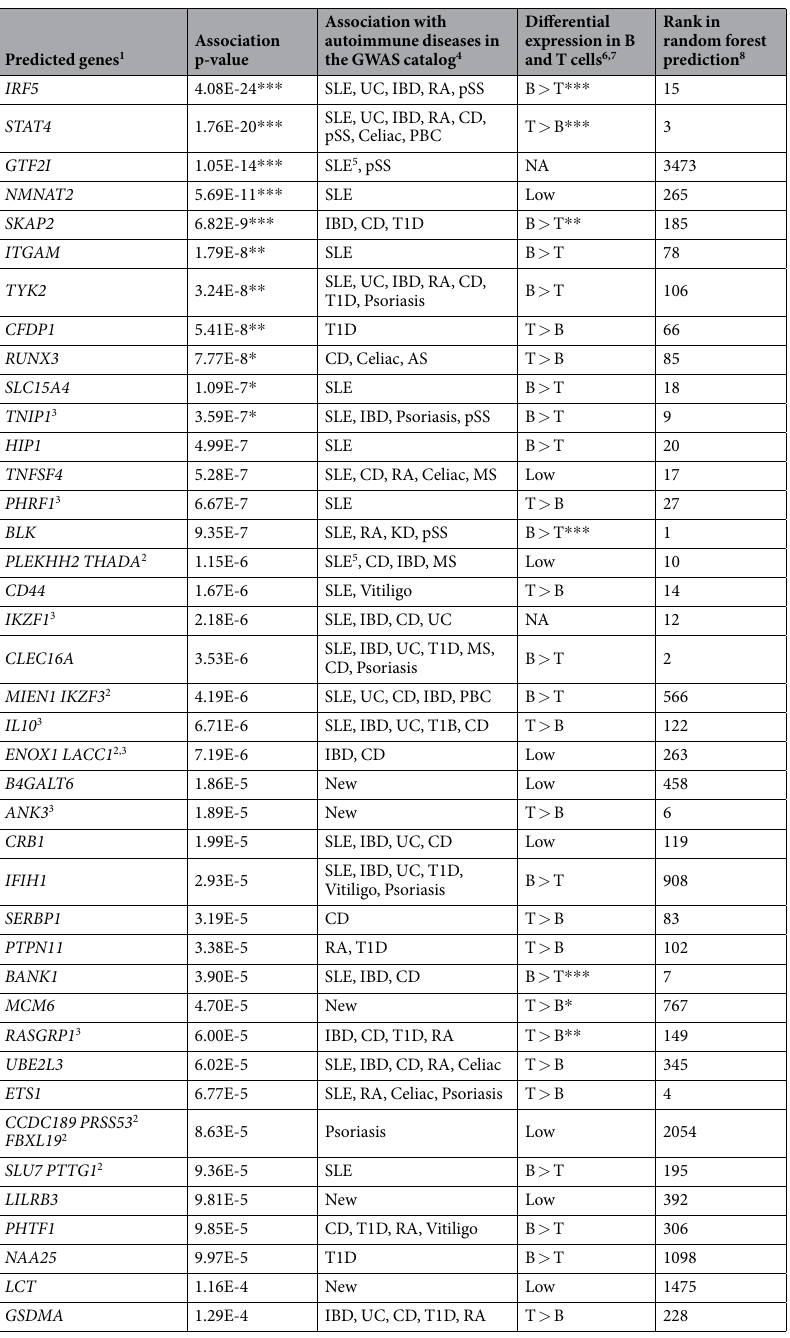
Table 2. Top 40 risk genes for SLE identified by the regular single SNP association using Immunochip genotype data from SLE patients and controls. 1 Human leukocyte antigen (HLA) genes not included, 2 Alternative candidate autoimmunity gene in the region reported in the GWAS catalog or functional studies, 3 Cis- regulatory SNP with significant association with allele-specific gene expression in B or T cells, 4 SLE = systemic lupus erythematosus, RA = rheumatoid arthritis, IBD = inflammatory bowel disease, CD = Crohn’s disease, T1D = diabetes mellitus type 1, MS = multiple sclerosis, PBC = primary biliary cirrhosis, UC = ulcerative colitis, KD = Kawasaki disease, pSS = primary Sjögren’s syndrome, New = previously unknown SLE risk gene, 5 Langefeld, C. D. et al . Transancestral mapping and genetic load in systemic lupus erythematosus, submitted manuscript, 6 Genes are annotated according to their expression level in B or T cells based on RNA-sequencing data, 7 Low = Expression below 1 FPKM for both cell types, 8 Gene ranking in the random forest prediction, * Bonferroni corrected p-value < 0.05, ** Bonferroni corrected p-value < 0.01, *** Bonferroni corrected p-value <